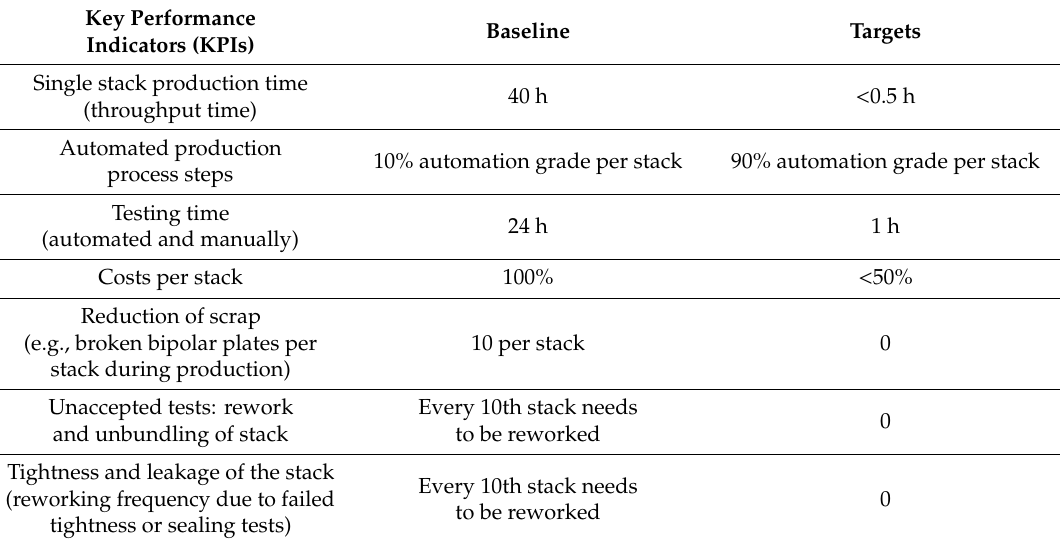
Table 1. Overview of the key performance indicators for PEMFC